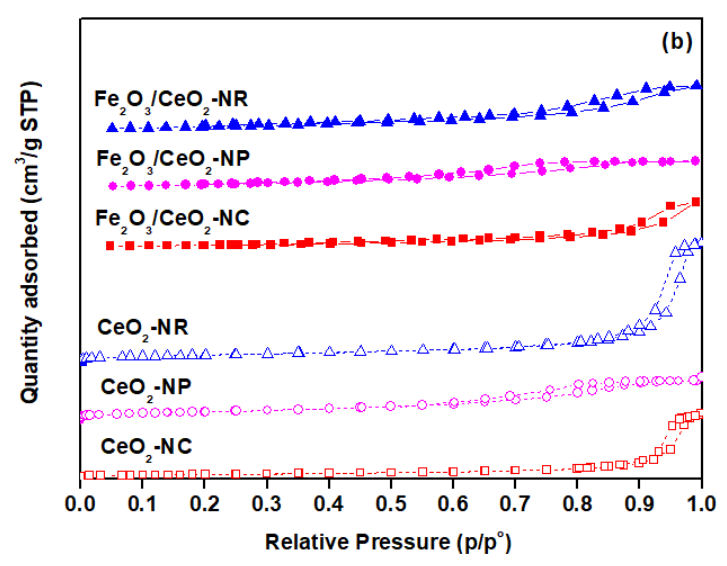
Figure 1. ( a ) Barrett–Joyner–Halenda (BJH) desorption pore size distribution (PSD) and ( b ) adsorption–desorption isotherms of bare CeO 2 and Fe 2 O 3 /CeO 2